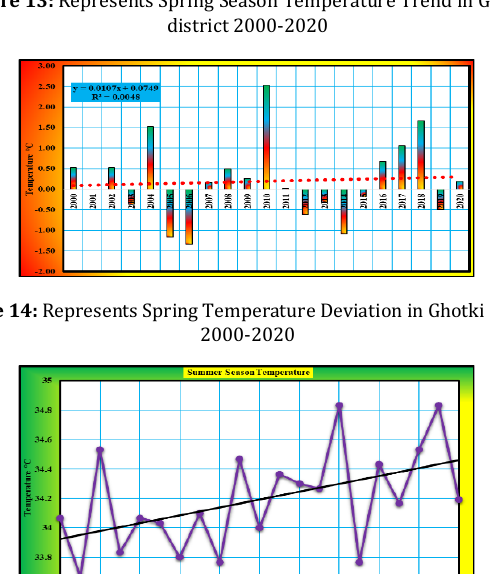
Figure 13: Represents Spring Season Temperature Trend in Ghotki